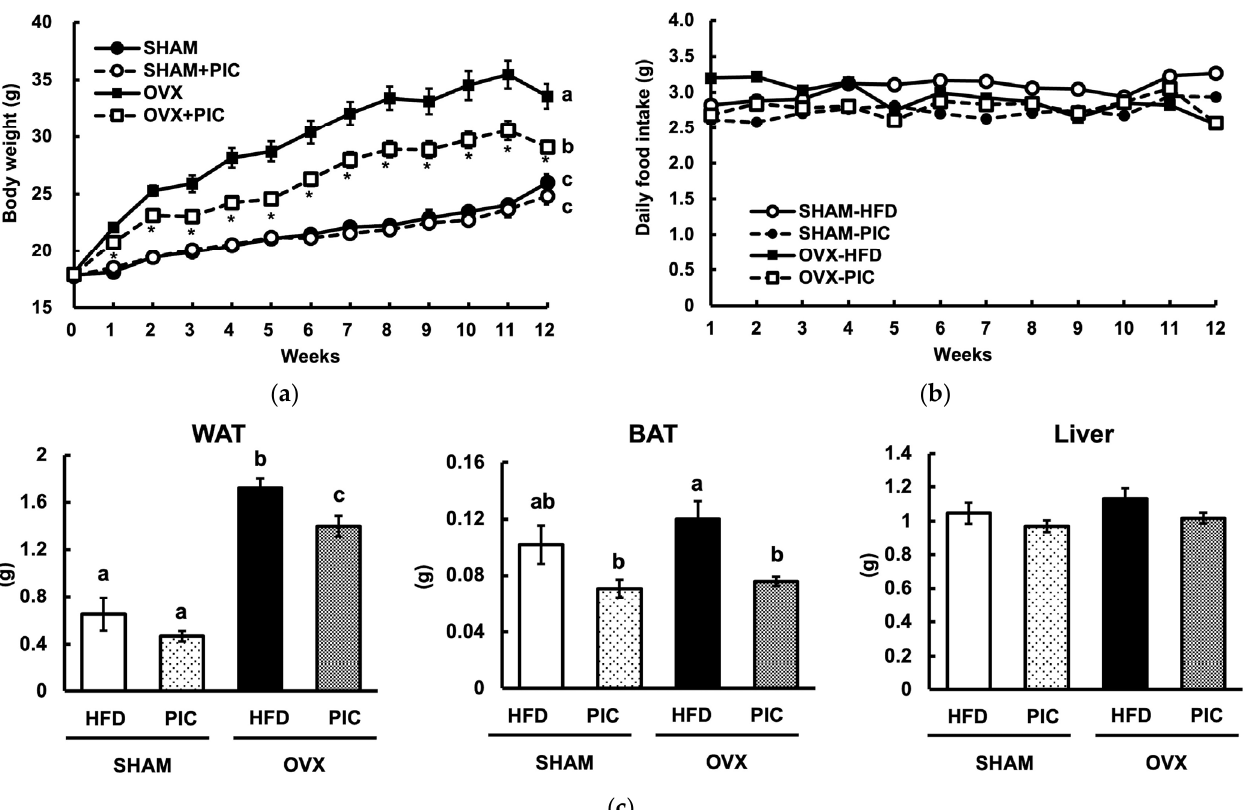
Figure 1. Effects of piceatannol on body weight and tissue weight in ovariectomized mice fed an HFD. ( a ) Weekly body weight measurements over 12 weeks; ( b ) daily food intake; and ( c ) weight of white adipose tissue present in the uterine cervix, interscapular brown adipose tissue, and liver. The data are presented as the means ± SE ( n = 5–6 per group), and values with different letters are considered significantly different ( p < 0.05) based on Tukey–Kramer’s test. Asterisk denotes significant different between the OVX-HFD and OVX-PIC groups (* p < 0.05).